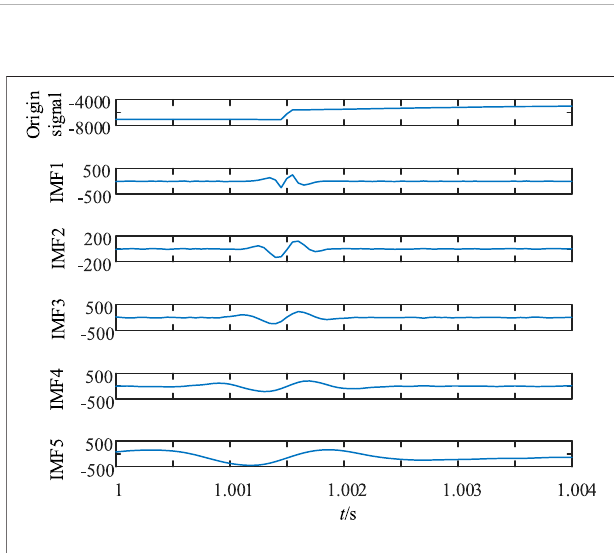
FIGURE 10 | Decomposition results of CEEMDAN.